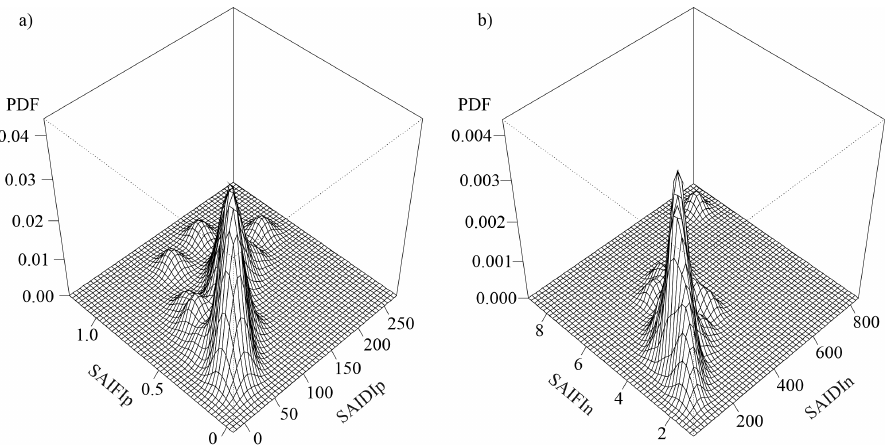
Figure 4. Two-dimensional density function obtained by means of KDE function for: ( a ) scheduled outages (SAIFIp, SAIDIp), ( b ) unplanned outages (SAIFIn, SAIDIn). Smoothing coefficients H have the